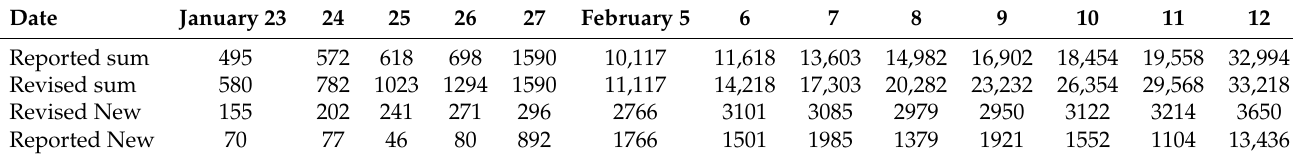
Table A1. The revised cumulative and the corresponding new confirmed